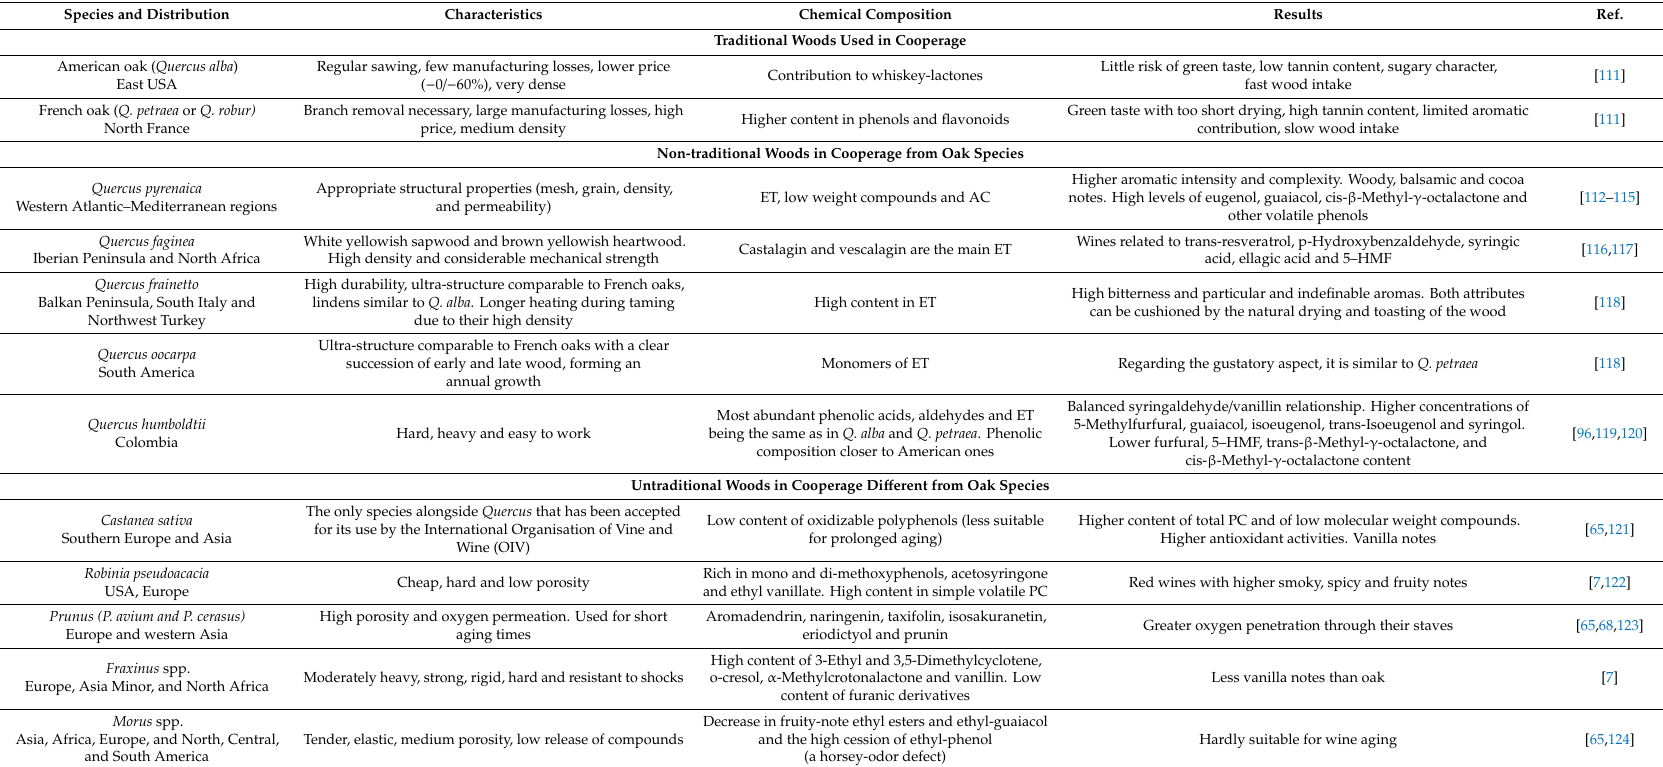
Table 1. Main species used in cooperage. Characteristics of the wood and properties of the resulting